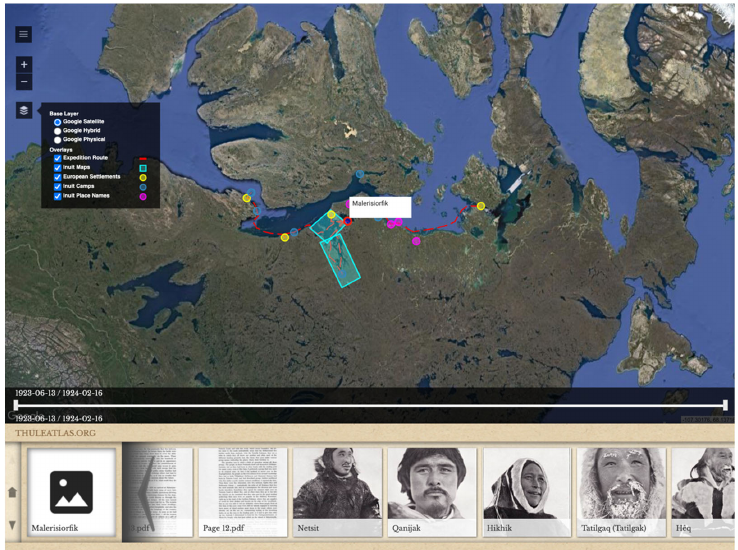
Figure 5. A geospatial map of the Fifth Thule Expedition’s course through the Inuinnait region. Clicking on a specific location summons the people, knowledge and collections sourced from that location.